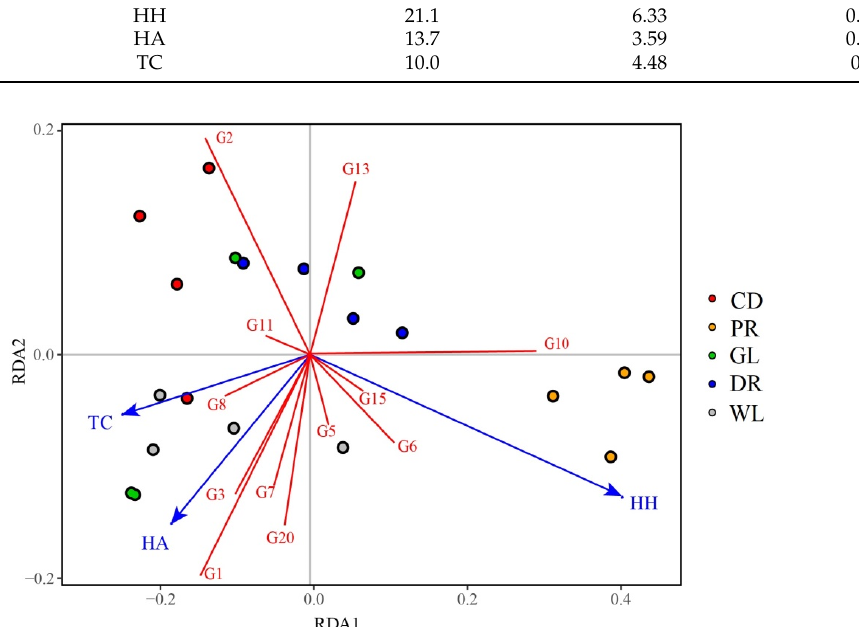
Figure 7. Canonical correlation analysis (RDA) ordination plot of epigeic arthropods and vegetation characteristics of field margins. The first axis explained 32.63% of the species—environment rela- tionship, whereas the second axis showed that the cumulative contribution rate was 8.63%. TC, HA, and HH represent tree layer cover, herbage layer abundance, and herb layer height. G1-G20 repre- sent different families of epigeic arthropods, as detailed in Table S1. GL, WL, CD, DR, and PR represent grassland, woodland, irrigation canals and ditches, dirt roads, and paved